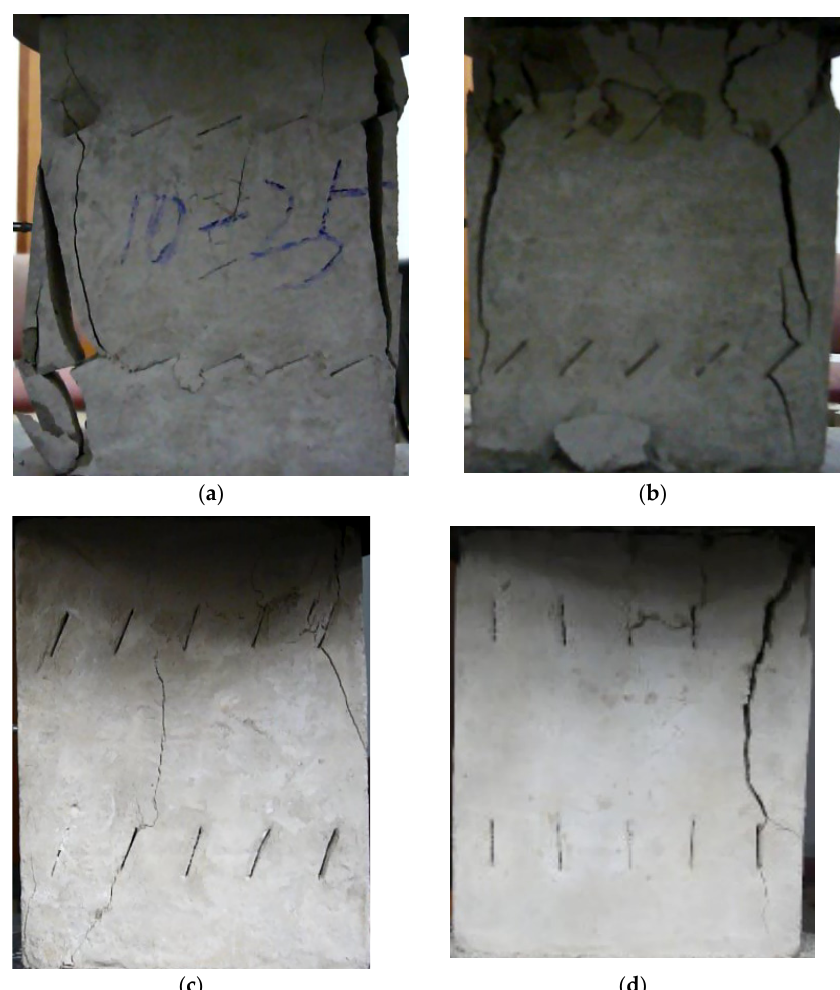
Figure 7. The failure process with 10 cracks. ( a ) 25°; ( b ) 45°; ( c ) 75°; ( d ) 90°.